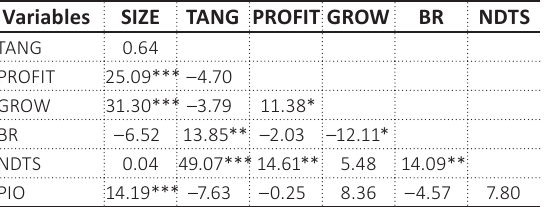
Table 3. Correlation coefficients between